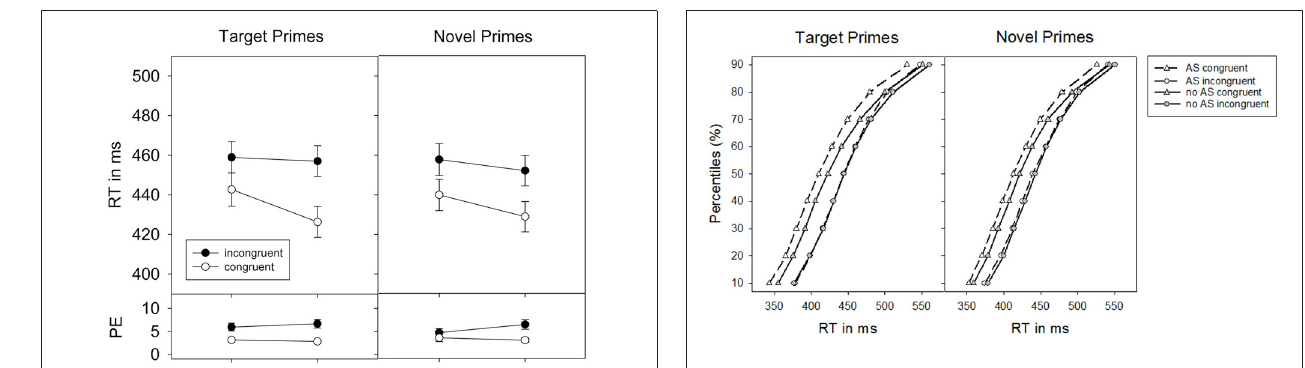
FIGURE 2 | Percentiles of participants’ response times (RTs) in Experiment 1 as a function of the absence vs. presence of an alerting signal for target primes and novel primes,